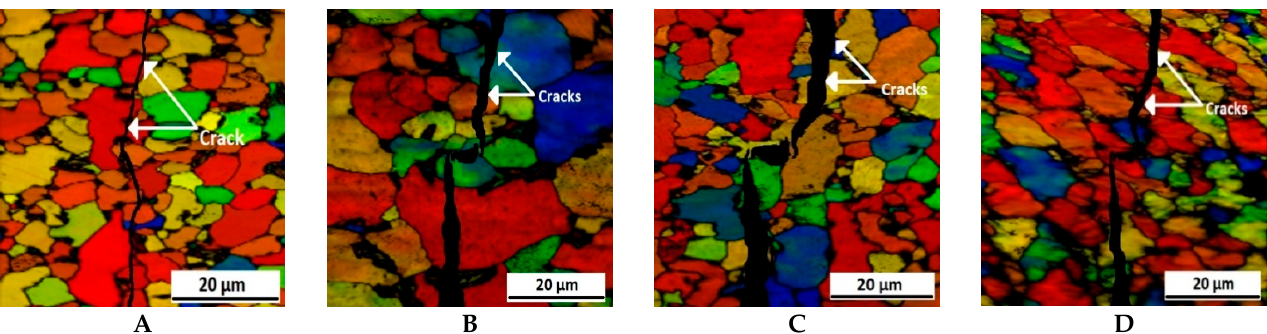
Figure 10. EBSD orientation micrograph of Al5083 alloy in 3.5% NaCl solution for ( A ) the as-received sample and samples after the ( B ) 1st pass, ( C ) 2nd pass, and ( D ) 3rd pass.